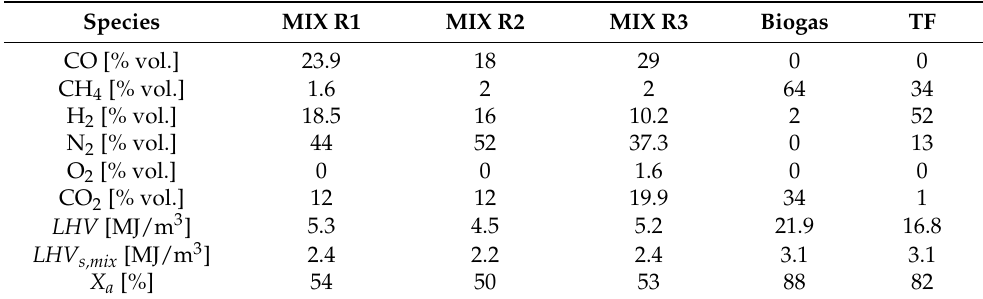
Table 2. Composition and related properties of the real syngas mixtures, biogas, and transition fuel chosen for this study on a dry basis, at 15 ◦ C and 1 bar. Species MIX R1 MIX R2 MIX R3 Biogas TF CO [%